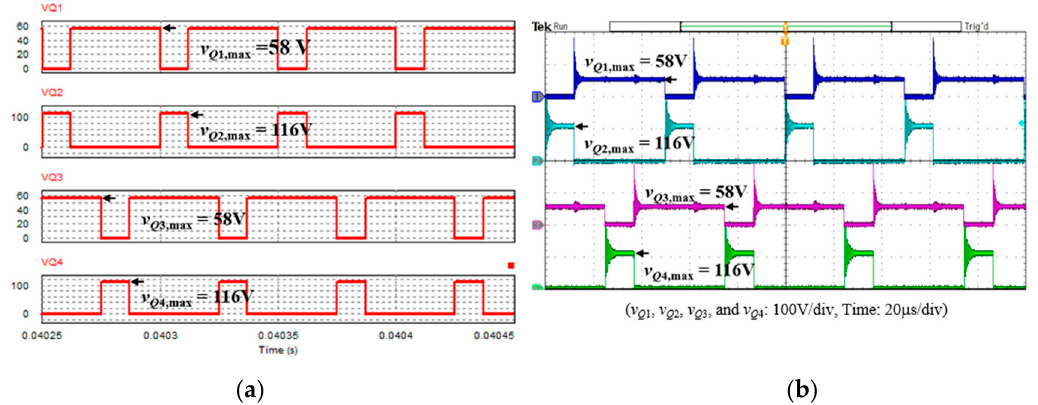
Figure 23. The waveform of switching voltage across the power devices in the dual-energy in series discharge mode with D d = 0.25: ( a ) simulated and ( b ) experimental.